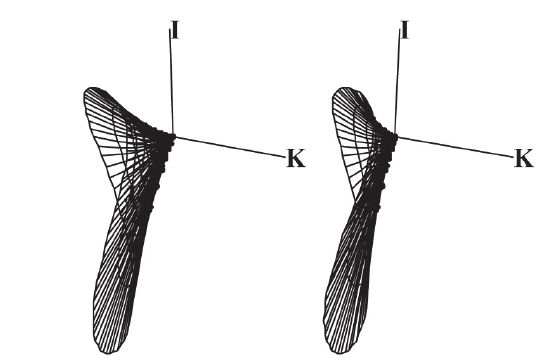
Figure 3: The surface of tilted powers in symmetric dioptric power space for a thin lens of antistigmatic power ( 1 0 ) F = D, or −1 2 × 90 in conventional terms. 0 1 0 The lens is in air ( n* =1) and has refractive index 1.5. The surface is self-intersecting and the origin is . The scale is an eighth of that the untilted power F 0 used in Figures 1 and 2.